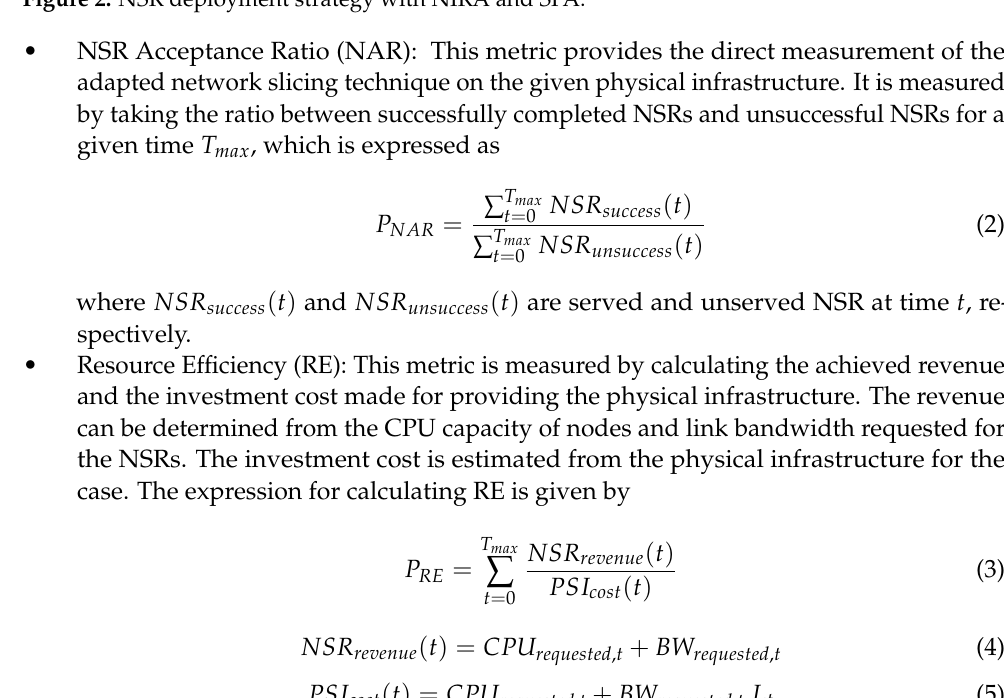
Figure 2. NSR deployment strategy with NIRA and